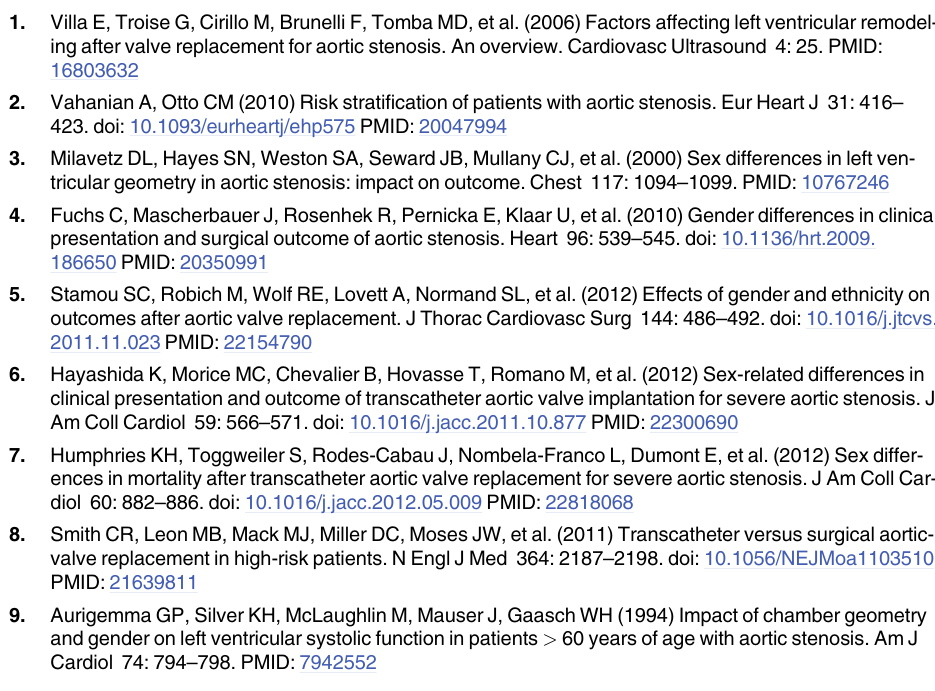
stenosis or valvuloarterial impedance, with the trabeculations and the papillary muscles in- cluded in the LV mass. Males consistently showed relatively higher left ventricular remodeling index in (A) larger aortic valve area index, (B) lower mean transaortic pressure gradient, or (C) lower valvuloarterial impedance, compared with females. However, there were significant dif- ferences between the two genders in the degree of correlation between the left ventricular re- modeling index and the above three parameters. The univariate linear regression coefficient and the interaction p value across the gender are shown. Abbreviations: AV, aortic valve; AVA, aortic valve area; CMR, cardiovascular magnetic resonance; PG, pressure